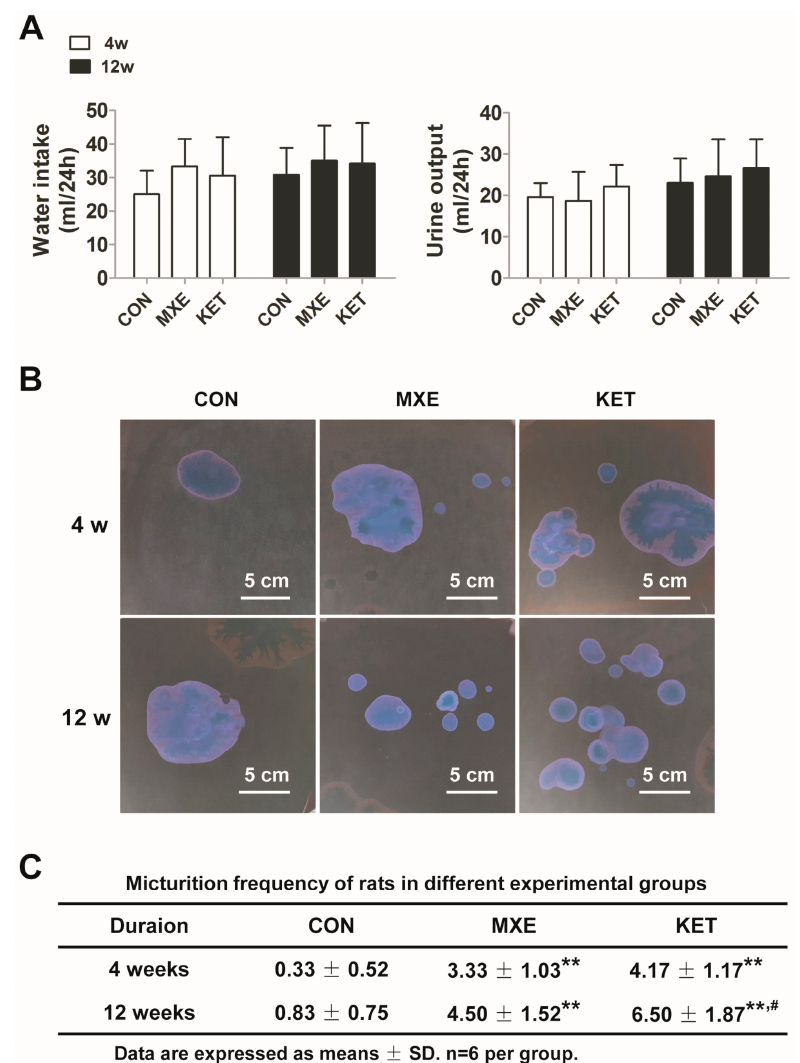
Figure 2. Water intake, urine output and micturition frequencies of rats after 4- and 12-weeks drug treatment. Rats were injected with normal saline (CON, n = 6), 30 mg/kg methoxetamine (MXE, n = 6) or 30 mg/kg ketamine (KET, n = 6) for a period of 12 weeks. ( A ) Changes in the 24h liquid balance in each group were examined after 12 weeks of treatment; ( B ) representative depictions of voiding